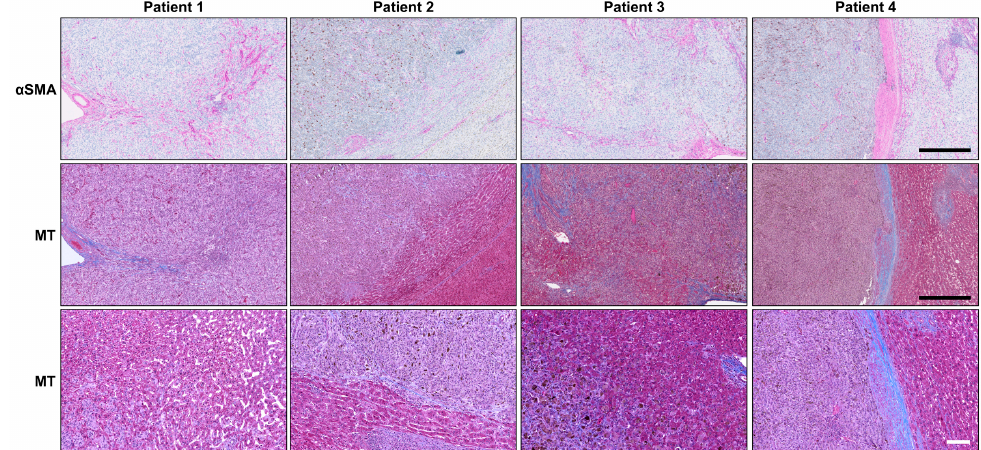
Figure 1. Activated HSteCs are abundant in UM patients’ liver macro-metastases. Immunohistological analyses of UM patients’ macro-metastases ( N = 4) using the α SMA antibody to label activated stellate cells; their positive signal appears in magenta (top panels). The accumulation of collagen produced by activated HSteCs is visible in blue in the vicinity of malignant lesions (MT; middle panels). The higher magnification of the invasive margin allows to determine the HGP for each metastasis (bottom panels). Black scale bars, 500 µm; white scale bar, 100 µm.